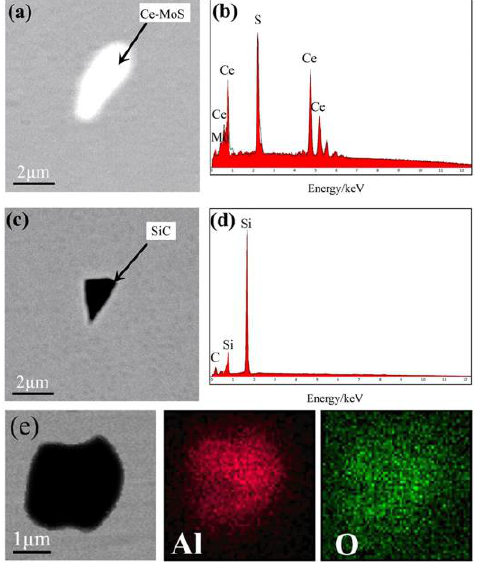
Figure 7. SEM images and EDS maps of other inclusions in ingot #2: ( a , b ) Ce ‐ MoS; ( c , d ) SiC; and ( e ) Al 2 O 3 .